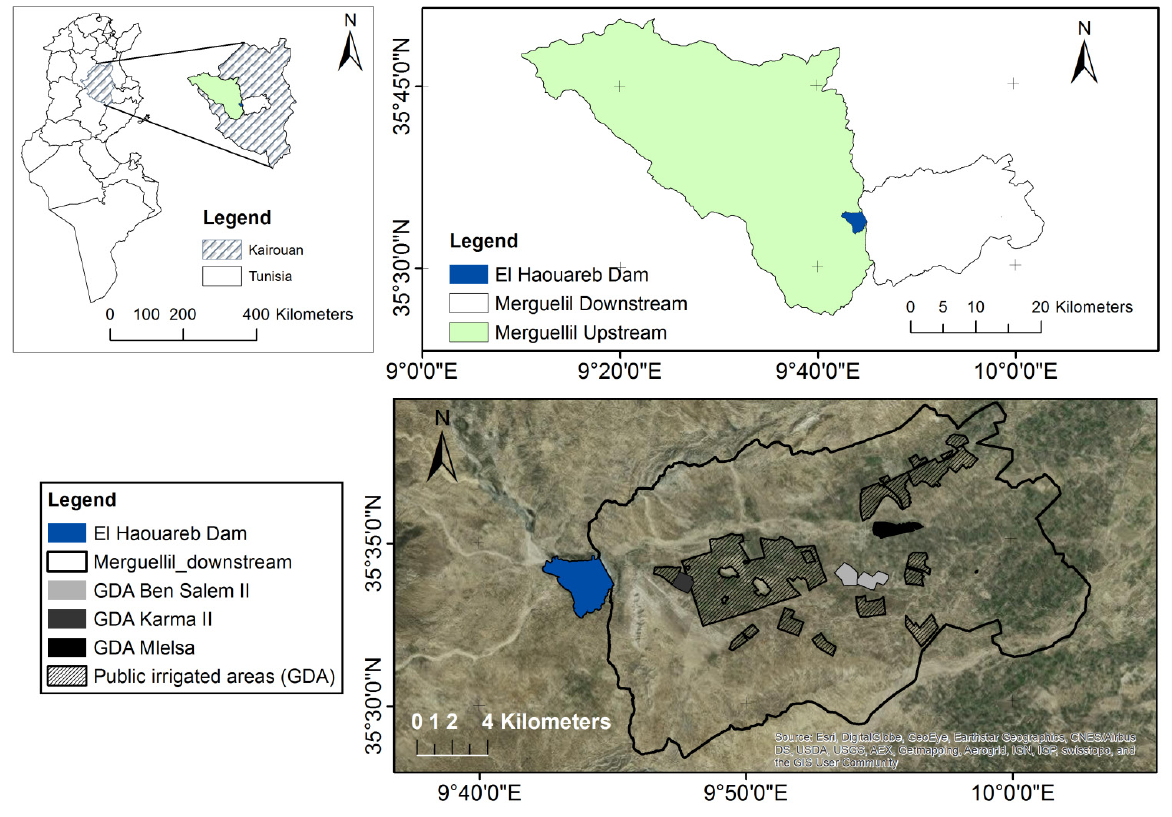
Figure 1. The study